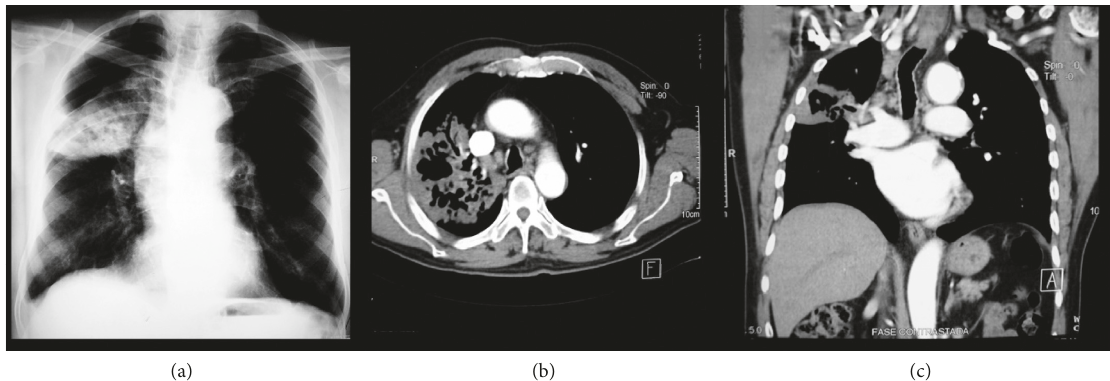
Figure 1: Necrotizing pneumonia due to Histoplasma capsulatum . (a) Chest X-ray (PA), with the presence of heterogeneous consolidation with radio lucid areas inside. (b, c) Chest CT showing lobar consolidation, cavitation in the right upper lobe, and parahilar